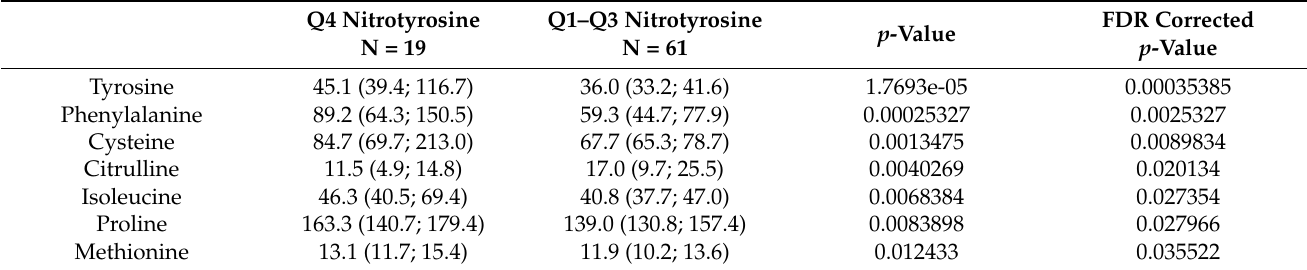
Table 2. Metabolites with significant differences between groups, according to a